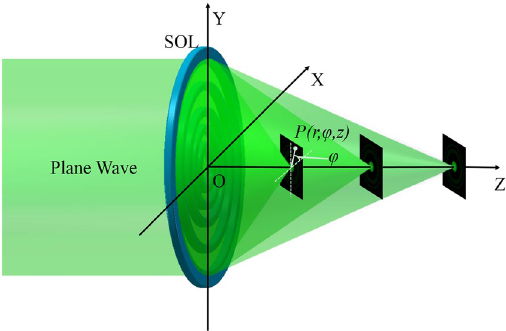
Figure 1. Schematic diagram of multiple sub-diffraction-limit focusing by a